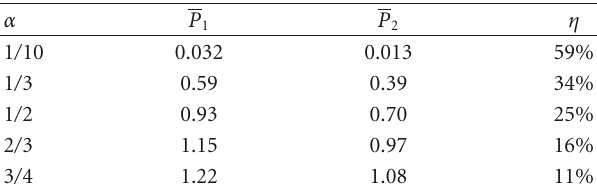
Table 1: Average power required for target U = 0 . 7, lightly smoothed flow ( P 1 ), heavily smoothed flow ( P 2